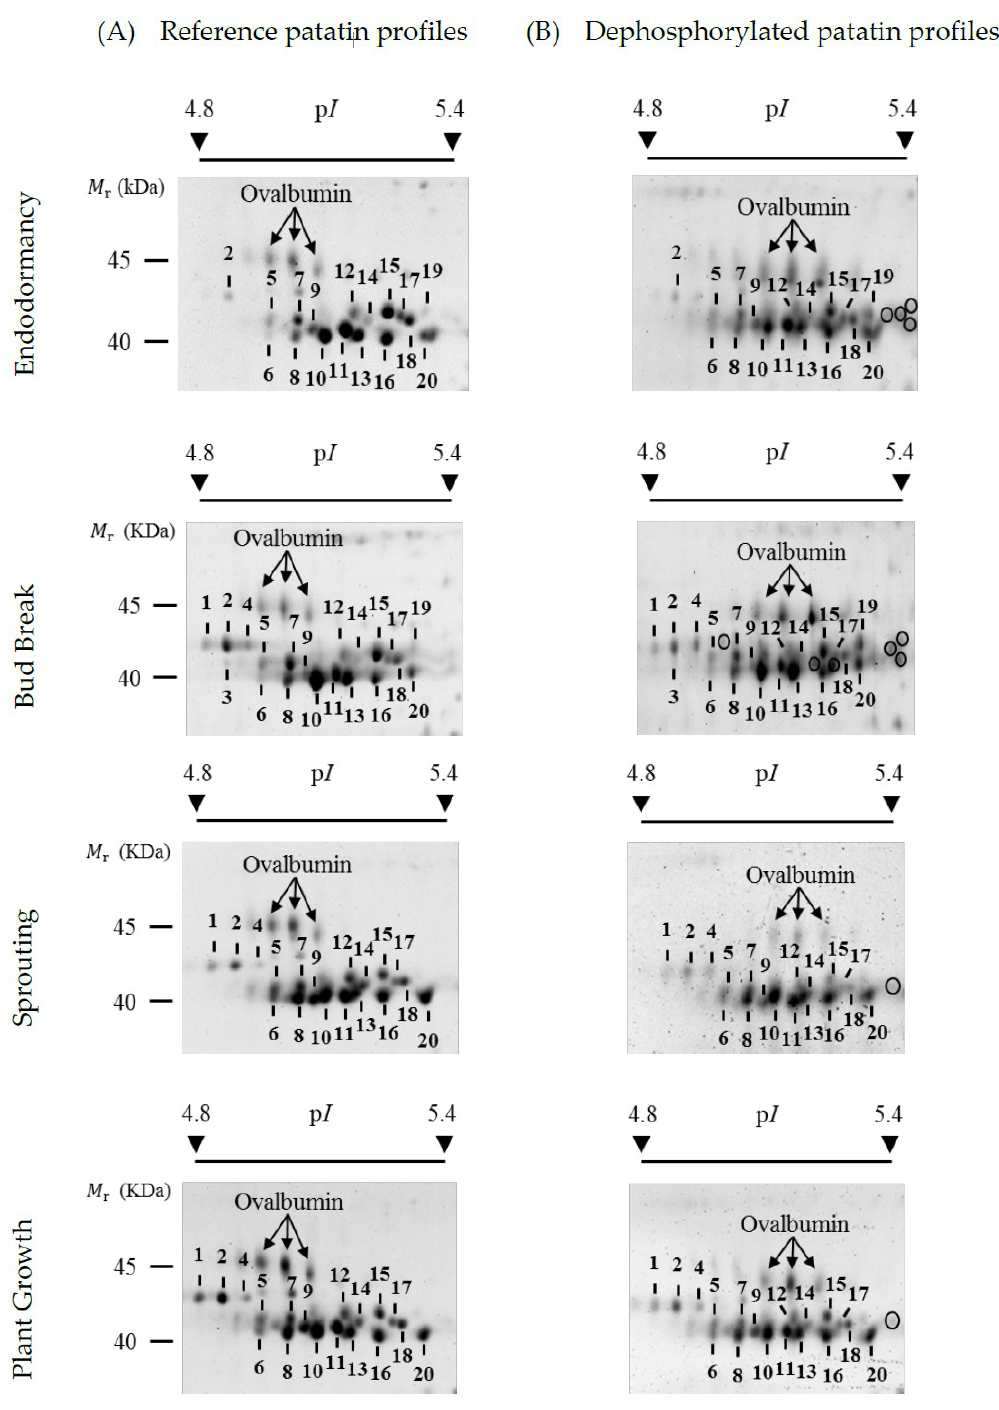
Figure 2. Representative two-dimensional electrophoresis (2-DE) gel images of reference and dephosphorylated profiles of patatin at four di ff erent tuber life stages of the Kennebec cultivar: endodormancy, bud break, sprouting and plant growth. ( A ) Reference profiles on 2-DE gels stained with Pro-Q Diamond and post-stained with SYPRO Ruby fluorescent dyes. Phosphorylated patatin spots are numbered. ( B ) Dephosphorylated patatin profiles on 2-DE gels stained with SYPRO Ruby from total tuber protein extracts treated with hydrogen fluoride-pyridine (HF-P). Circles show the gel position of newly arisen patatin spots following chemical dephosphorylation with HF-P. The arrows indicate the gel position of ovalbumin (45.0 kDa) phosphoprotein